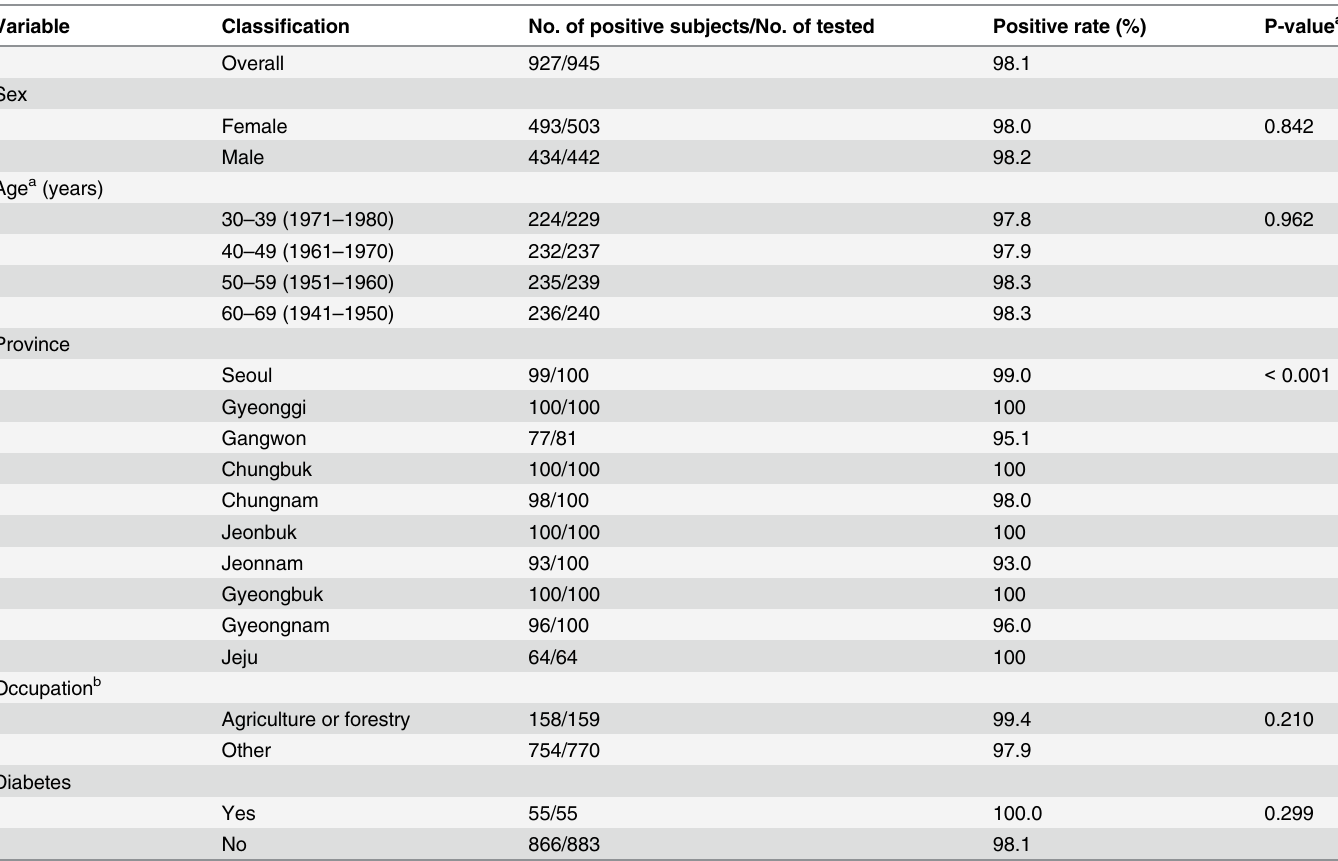
Table 3. Prevalence of neutralizing antibodies to Japanese encephalitis